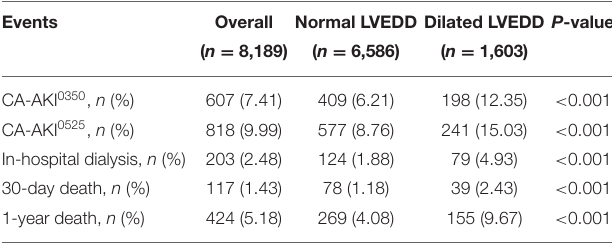
outcomes. Events